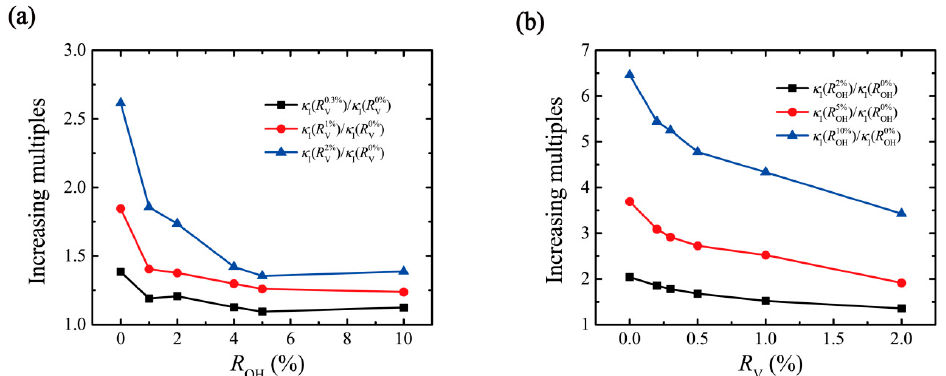
Figure 5. ( a ) The increasing multiples of κ I due to the degree of oxidation as a function of the vacancy defect ratio. ( b ) The increasing multiples of κ I due to vacancy defect as a function of the degree of oxidation.